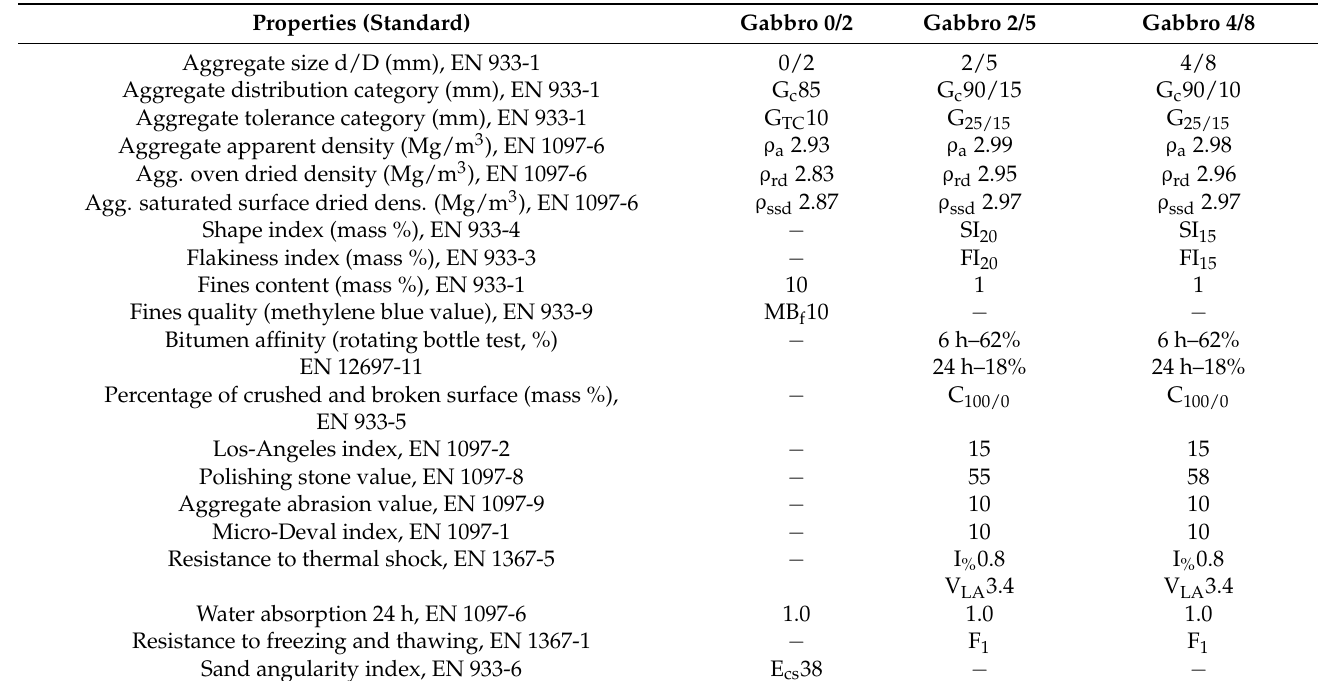
Table A2. Properties of gabbro aggregate used in “G” type mixes (results by the producer).